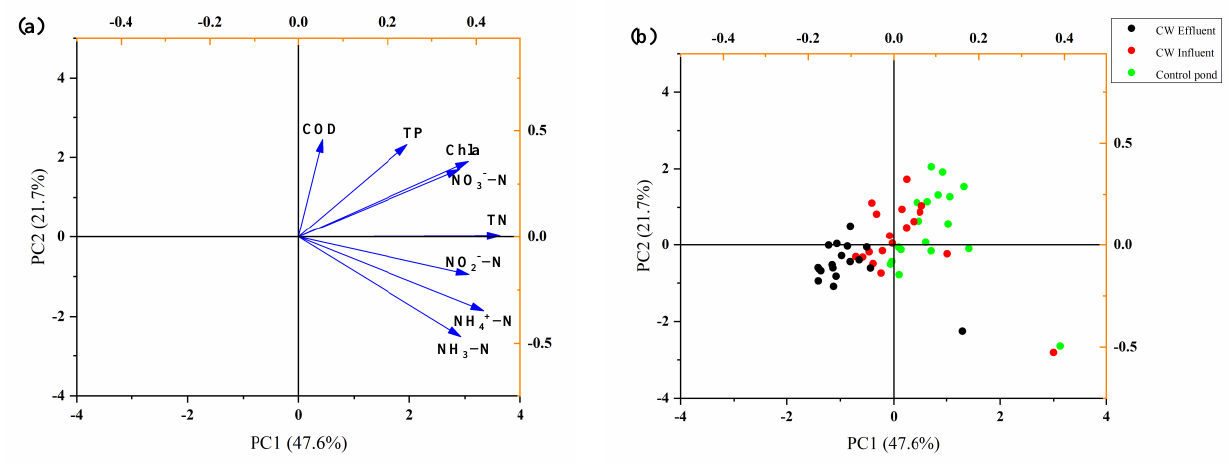
Figure 8. Plot of the principal component analysis (PCA) variables ( a ) and scores applied to different sampling sites ( b ) .